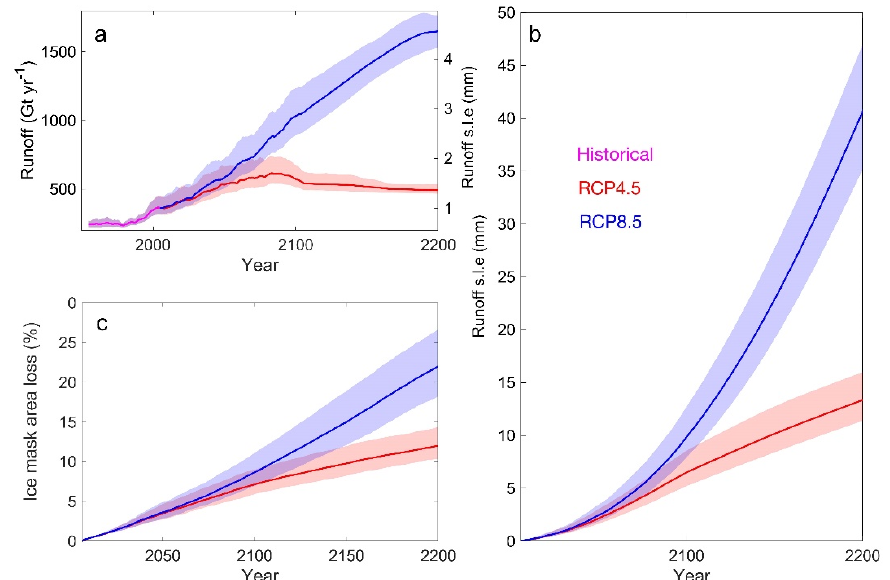
Figure 9. ( a ) Modeled annual runoff by the average of two DD methods in the period 1950–2005 under the historical scenario (magenta), and 2006–2200 under RCP4.5 (red) and RCP8.5 (blue) and their extensions. ( b ) Cumulative runoff equivalent to global mean sea-level rise during 2006–2200 under RCP4.5 (red) and RCP8.5 (blue) relative to 1950–2005. ( c ) Same as ( b ), however for ice area loss. Colored shading indicates the spread using different DDFs .